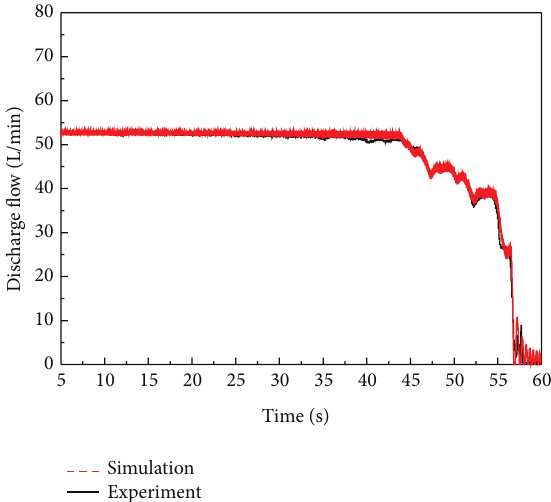
Figure 21: Simulation and experimental results for motor torque.